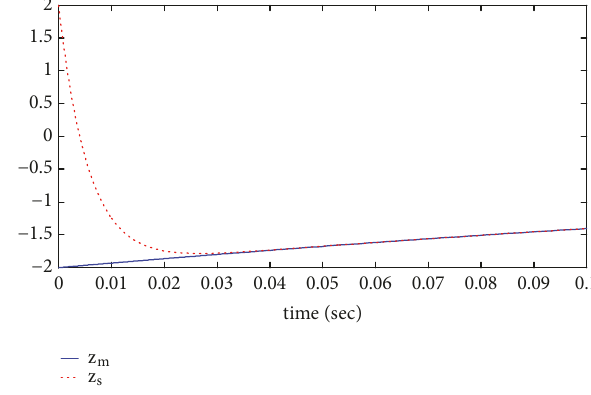
Figure 5: Synchronization process between slave state 𝑧 𝑠 and master state 𝑧 𝑚 .